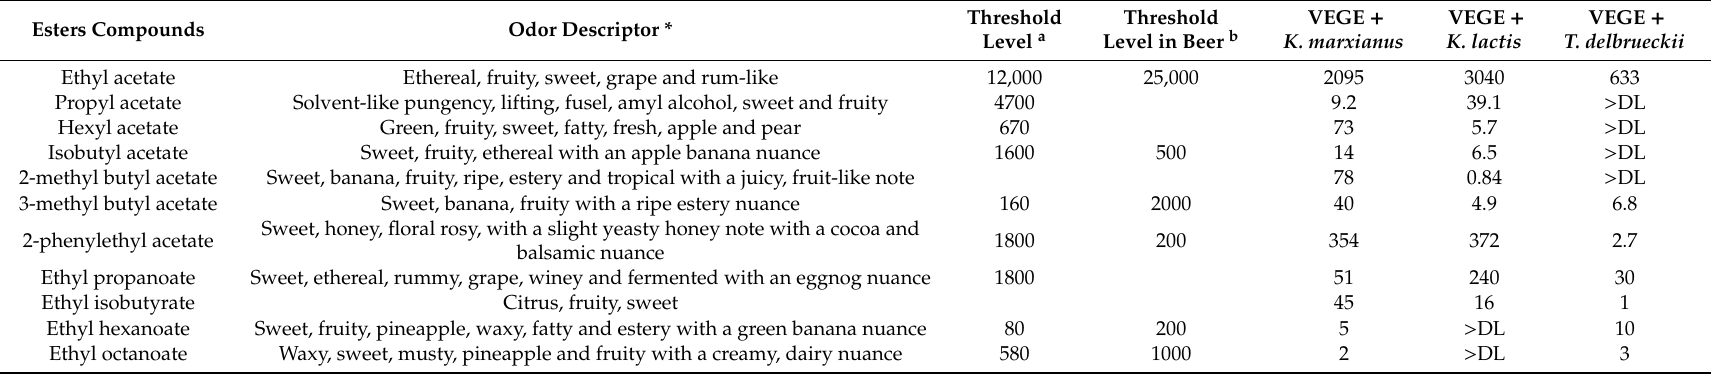
Table 4. Concentrations of esters in the fermented samples with yeasts ( µ g /